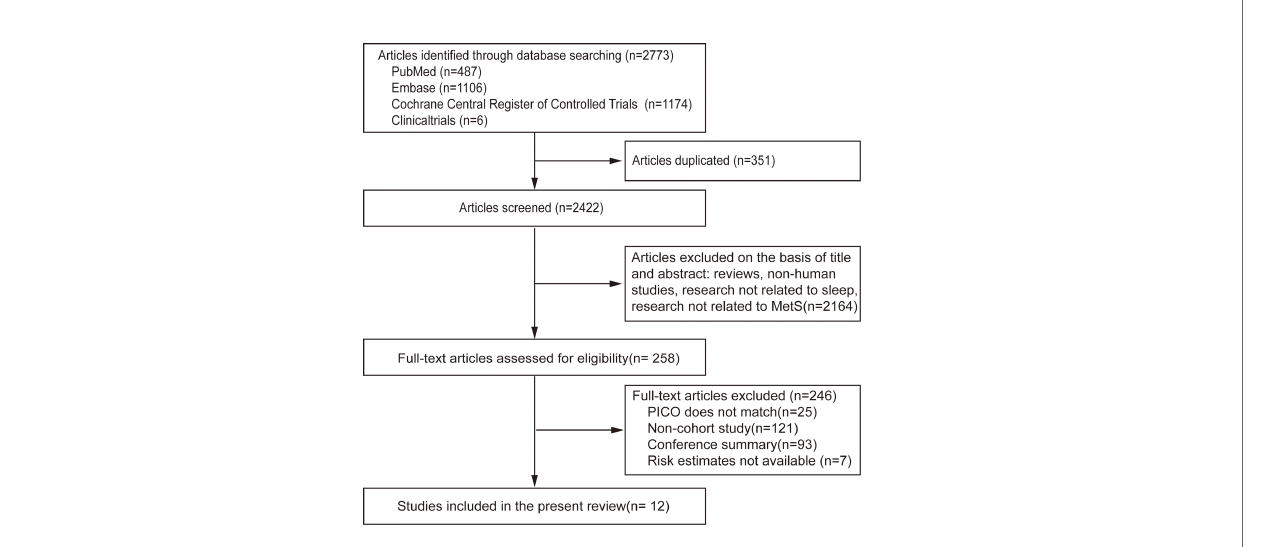
FIGURE 1 | Flow chart of meta-analysis for exclusion/inclusion of individual